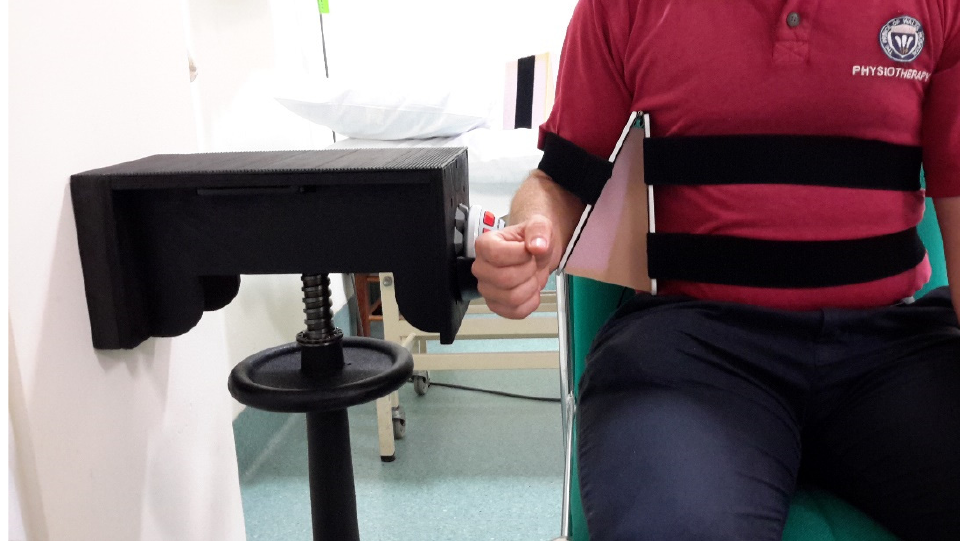
Figure 4. Isometric ER strength testing position with the arm apparatus under the patient’s axilla and an inserted foam wedge for 30° abduction as per Kolber et al. [43].